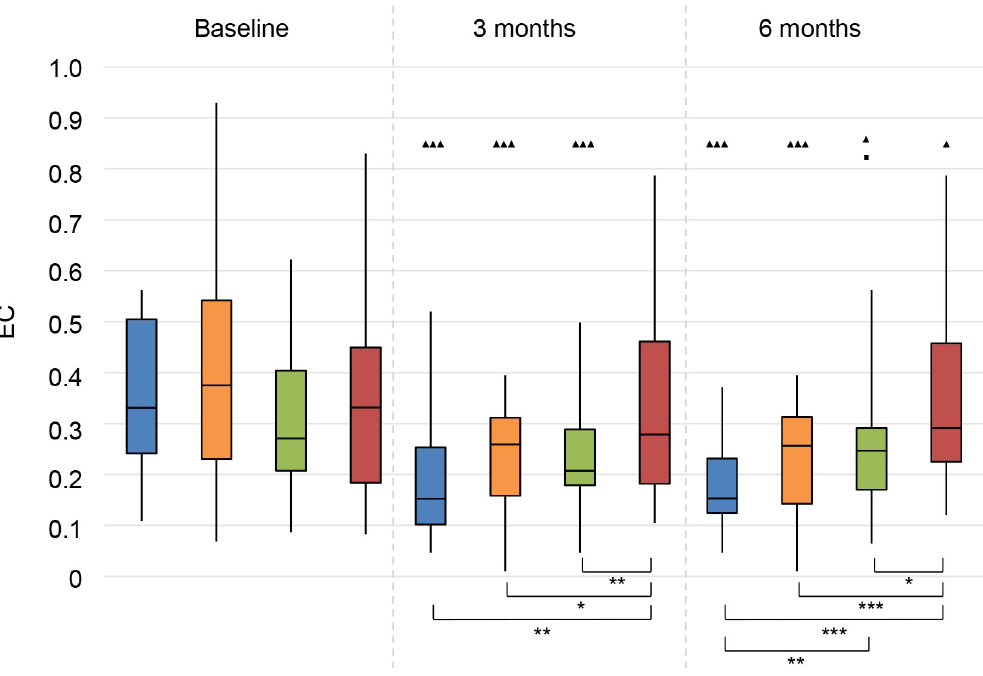
Fig 13. Abbreviated Profile for Hearing Aid Benefit questionnaire (APHAB). Ease of communication (EC). Statistical difference compared to baseline. ▲▲▲ = p < 0.001; ▲▲ = p < 0.01; ▲ = p < 0.05. Statistical difference compared to 3 months follow-up. ■■■ = p < 0.001; ■■ = p < 0.01; ■ = p < 0.05. Statistical difference between groups at same follow-up moment. ��� = p < 0.001; �� = p < 0.01; � = p <